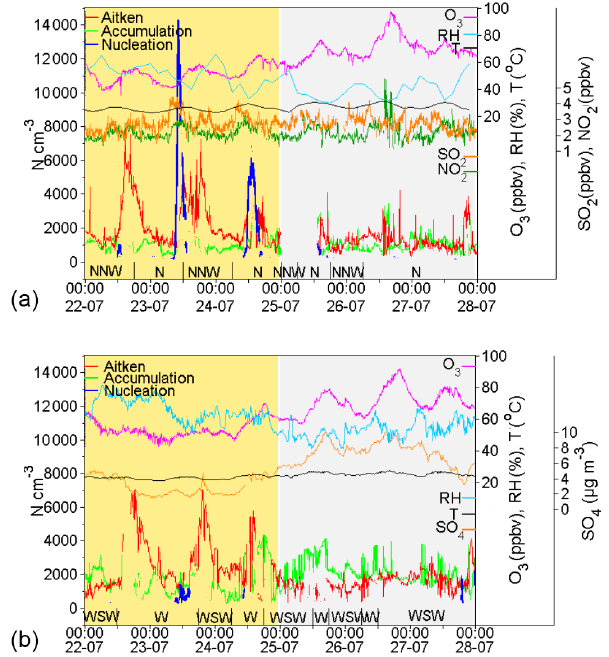
Figure 4. Aerosol modal number concentrations and pollutant (O 3 , NO 2 when available) concentrations, along with meteorological pa- rameters of relative humidity (RH) and surface temperature ( T ) at Santorini (top panel) and Finokalia (bottom panel). Note that SO 2 is shown at Santorini, while SO 4 is shown for